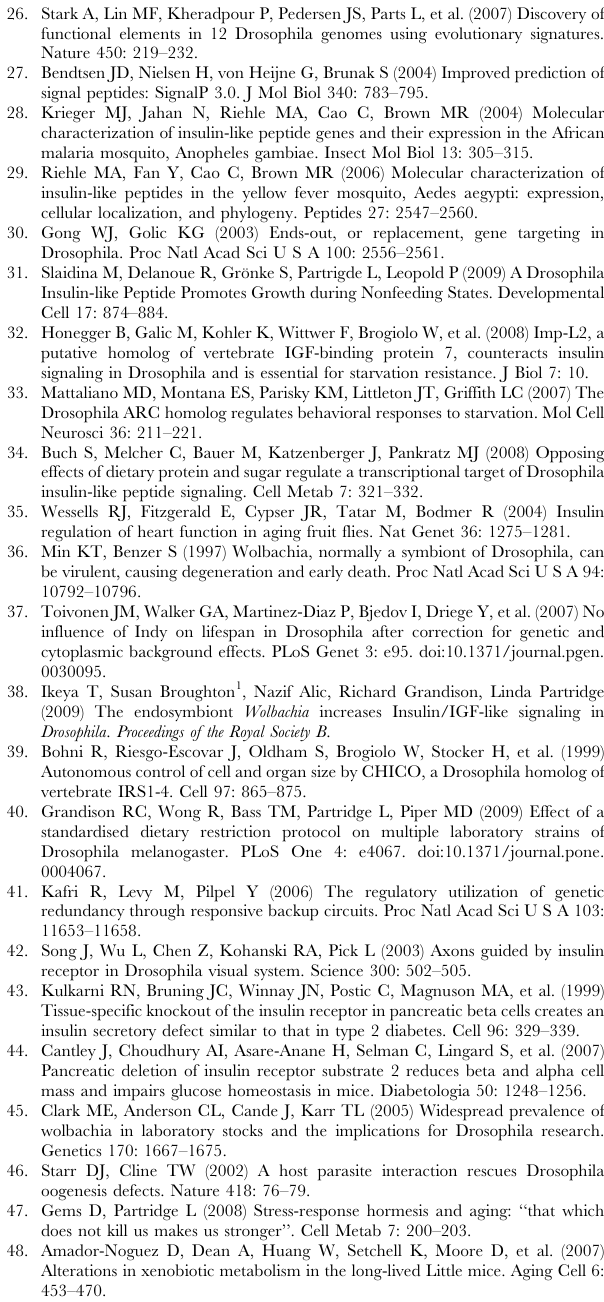
Table S3 PCR oligonucleotide primer.